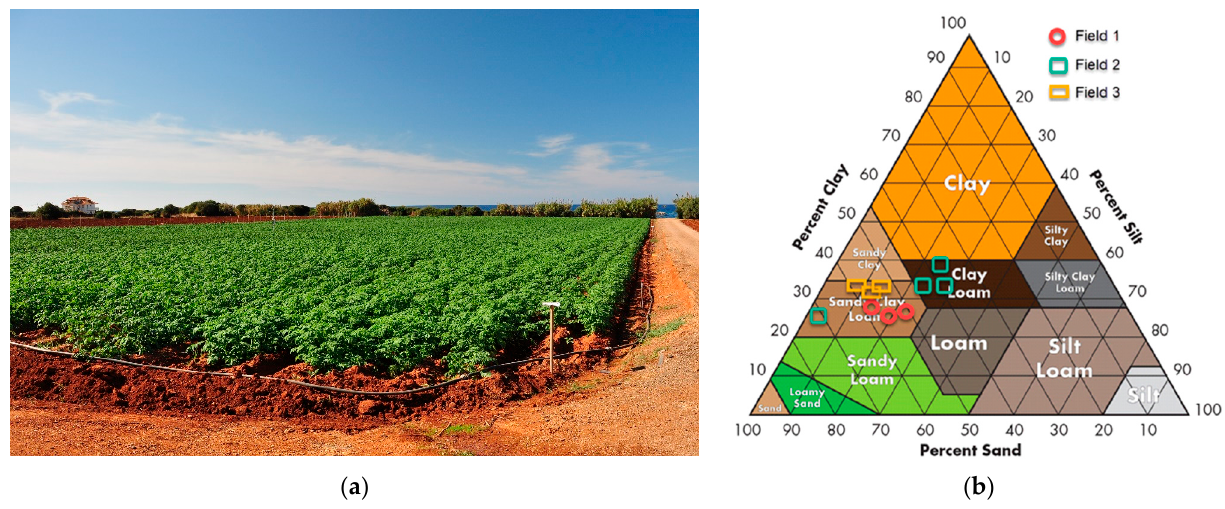
Figure 4. ( a ) Experimental field 2 with the potato cultivation; ( b ) categorization of the soils of the three experimental fields at depths of 0–20, 20–40, and 40–60 cm in the soil triangle. The soil texture classification according to the USDA (U.S. Department of Agriculture).